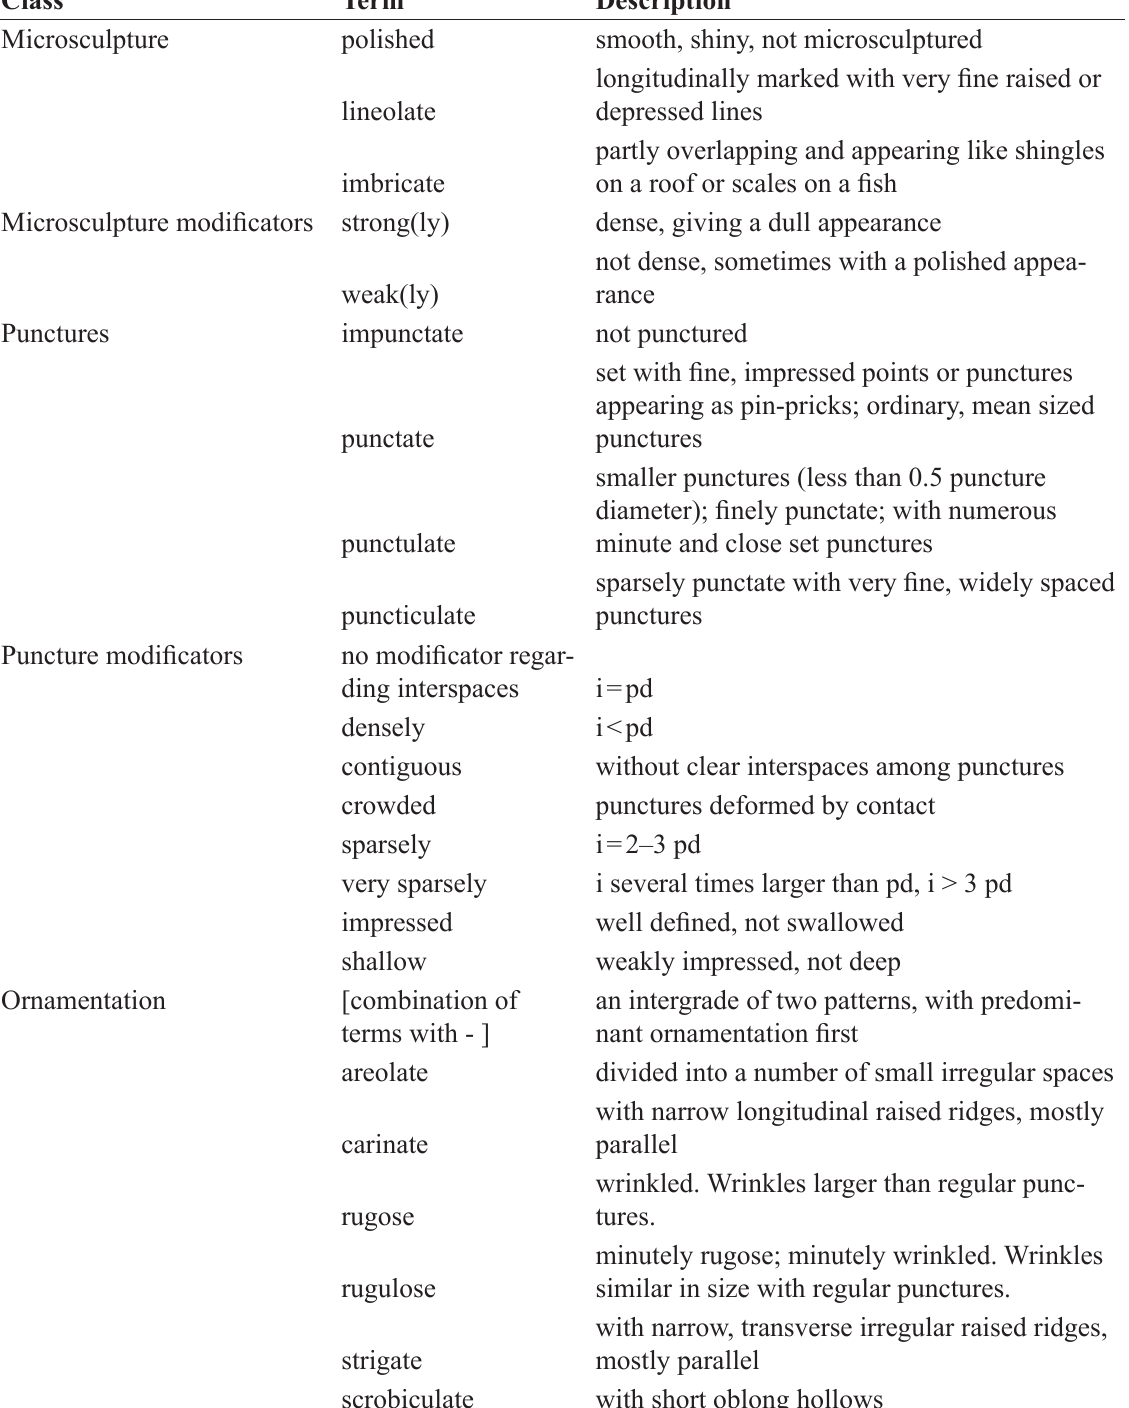
Table 1. Sculpture terminology used here, modified from Harris (1978). Abbreviations: i = puncture interspaces; pd = puncture